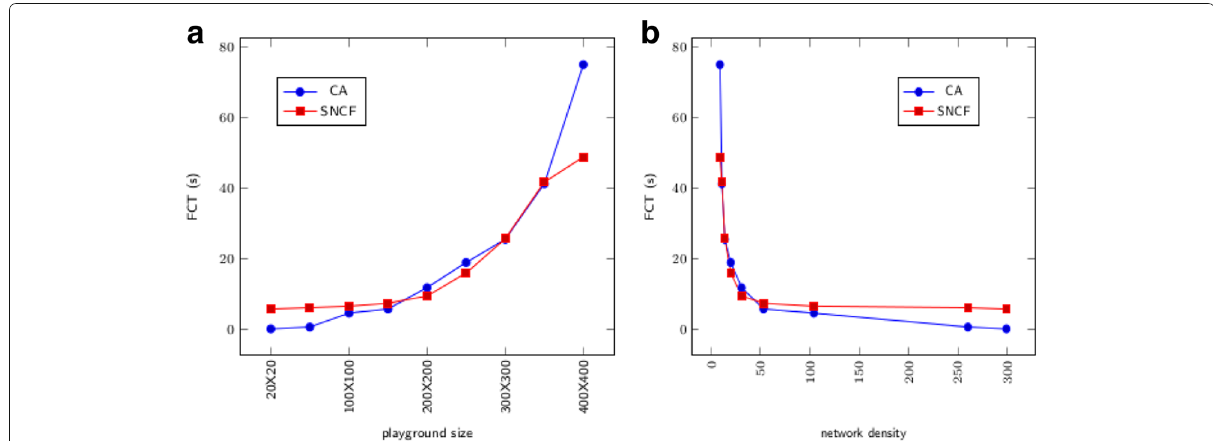
Fig. 25 Latency of CA protocol in terms of flooding completion time (FCT) in comparison with simple flooding. a Against playground size. b Against node density